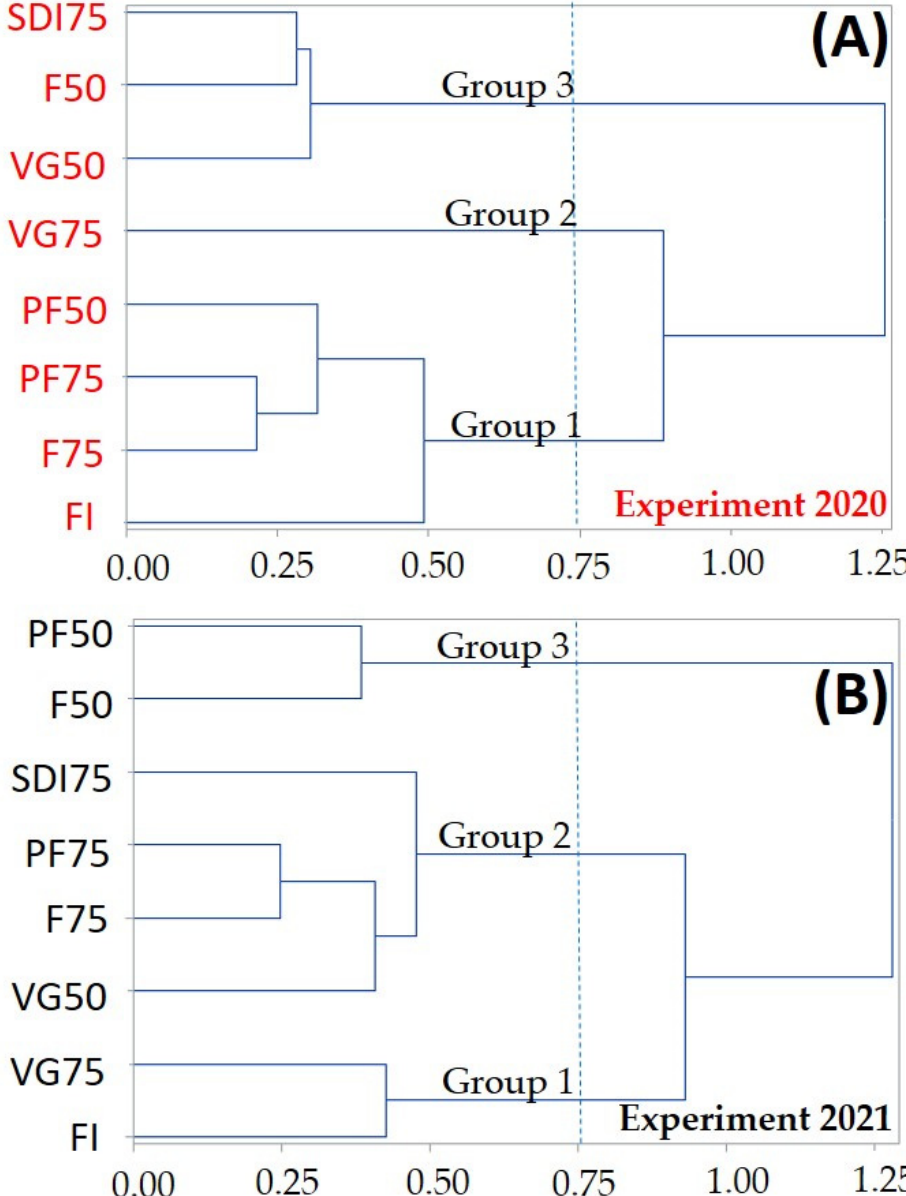
Figure 8. Treatment cluster analysis in ( A ) experiment 2020 and ( B ) experiment 2021. Vegeta- tive growth (VG), flowering (F), and pod-filling (PF) stages. RDI = regulated deficit irrigation. FI = full irrigation application of 100% ETc during VG, F and PF. SDI 75 = sustained deficit irrigation applying 75% of ETc during VG, F, and PF. VG 50 = RDI applying irrigation equivalent to 50% of ETc in VG. VG 75 = RDI applying irrigation equivalent to 75% of ETc in VG. F 50 = RDI applying irrigation equivalent to 50% of ETc in F. F 75 = RDI applying irrigation equivalent to 75% of ETc in F. PF 50 = RDI applying irrigation equivalent to 50% of ETc in PF. PF 75 = RDI applying irrigation equivalent to 50% of ETc in